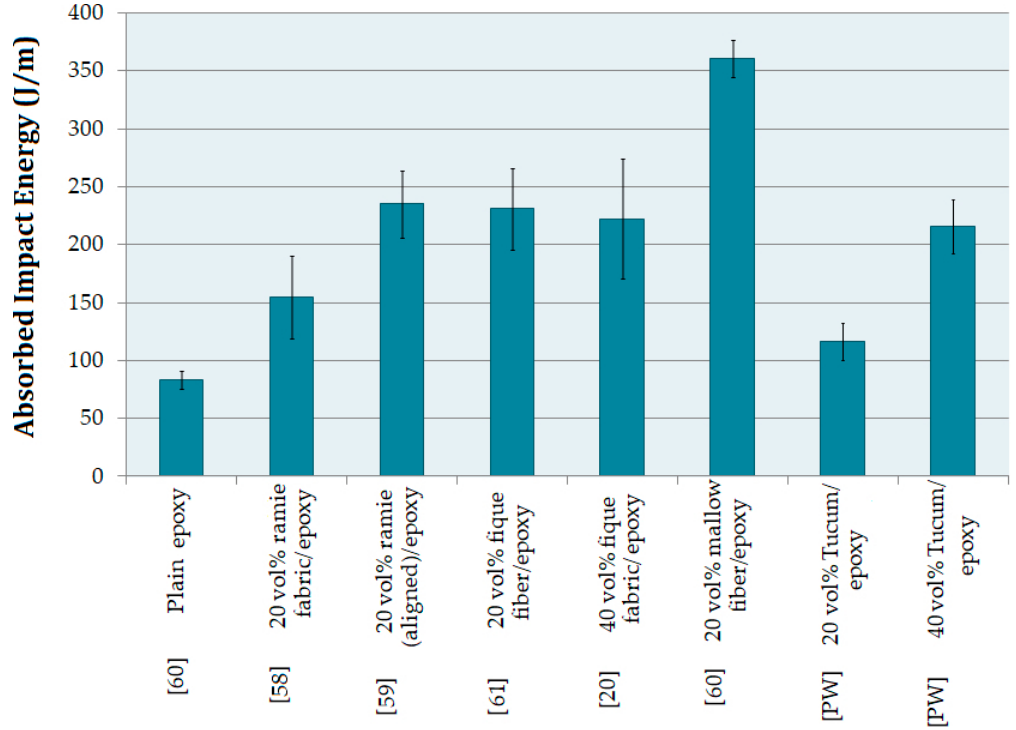
Figure 11. Energy absorbed by epoxy-NLFs composites by the Izod impact for several epoxy composites reinforced by natural fibers and fabrics (Present Work (PW)).